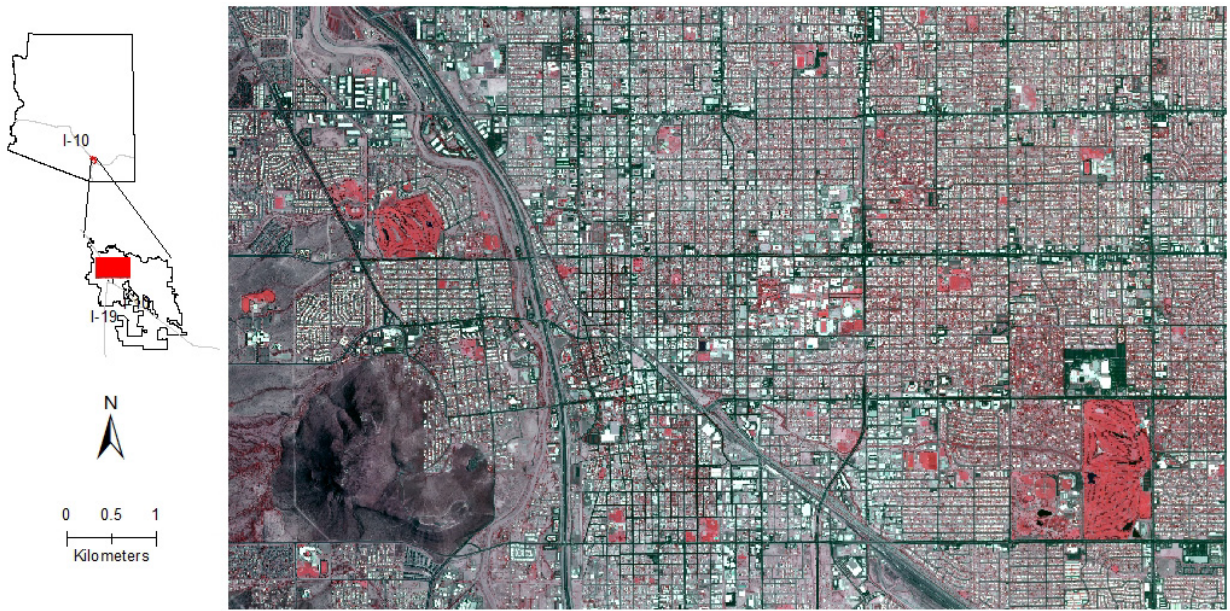
Figure 1. Near-infrared, red, and green false color composite of a mosaic of the multispectral NAIP (National Agricultural Imaging Program) images of the urban study area in Tucson (AZ, USA) that were acquired 23–25 June 2007. The majority of the red colored areas are irrigated golf courses, parks, sports fields, gardens and trees along streets. The dark colored Tumamoc Hill (lower left section) is a long term ecological observation site with desert vegetation on a mountainous area within the